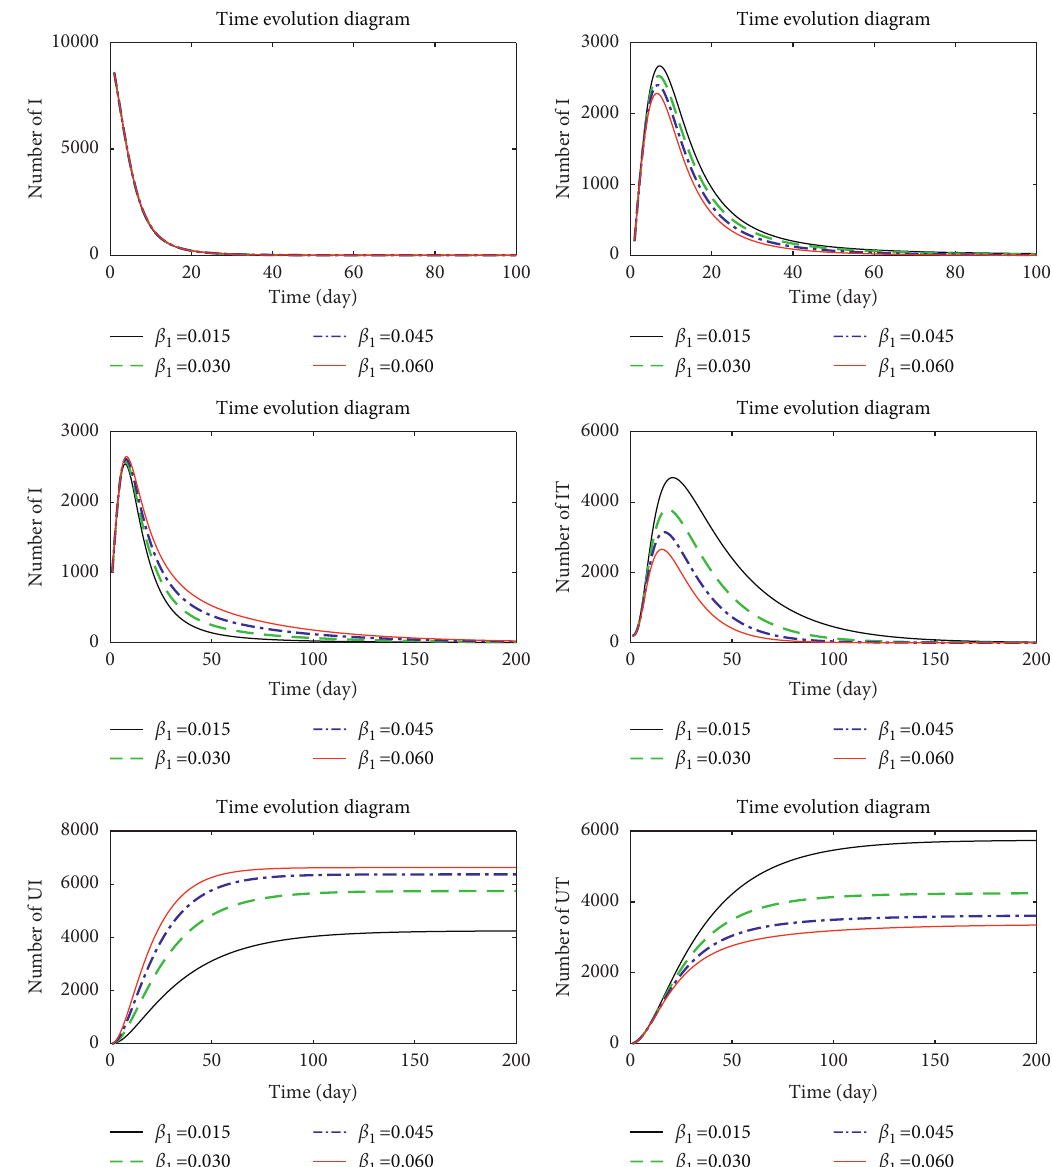
Figure 3: Time evolution graph of the number of nodes changing with a rate of β